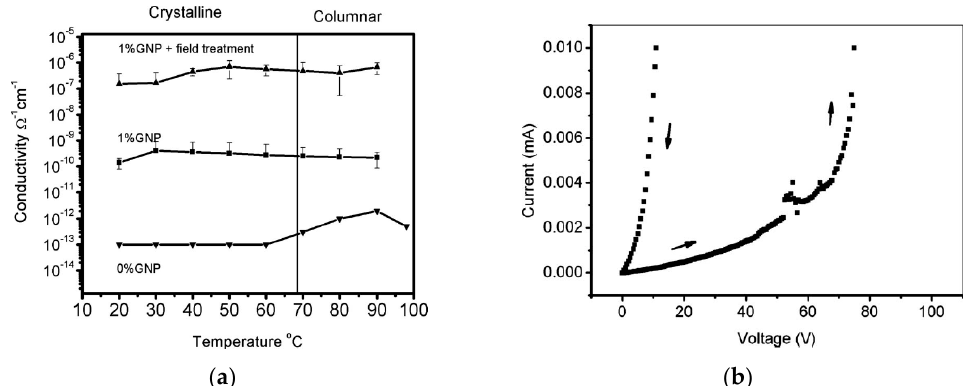
Figure 17. ( a ) The conductivity of a 1% GNP in HAT6 as a function of temperature; ( b ) the I-V sweep of a thin film of 5% GNP in HAT6 in the isotropic phase at 105 °C [93].